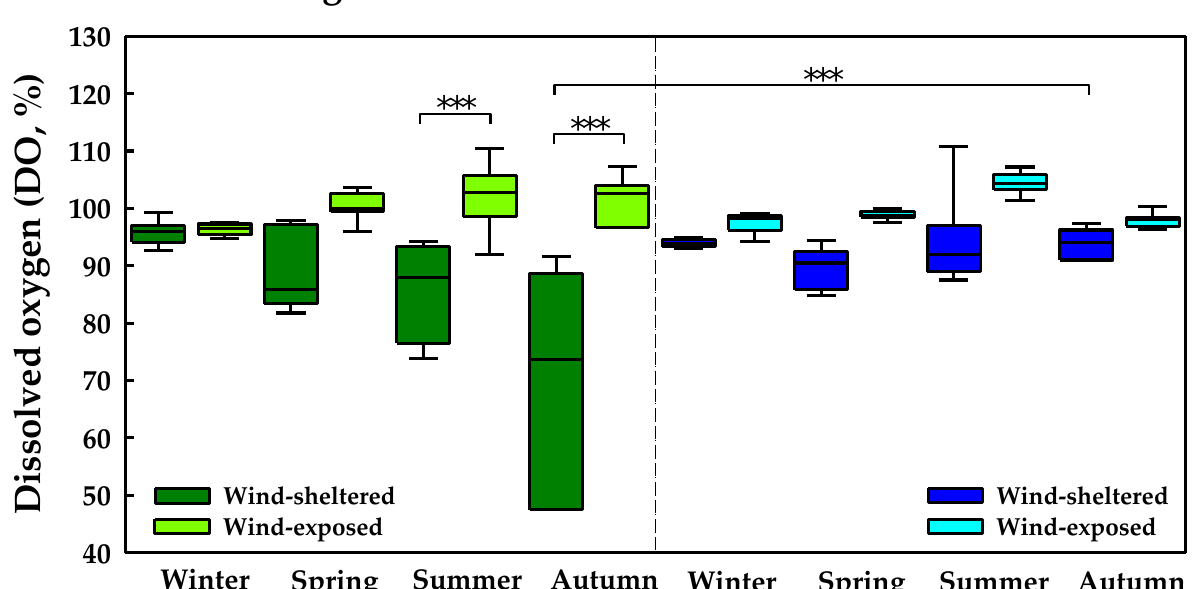
Figure 3. DO results from seasonal campaigns in PAR Lake. Measurements were carried out at wind-sheltered and -exposed sites, in vegetated and plant-free areas. For a better readability, Tukey’s HSD results are not reported for the seasonality factor. *** indicates p -value < 0.001.